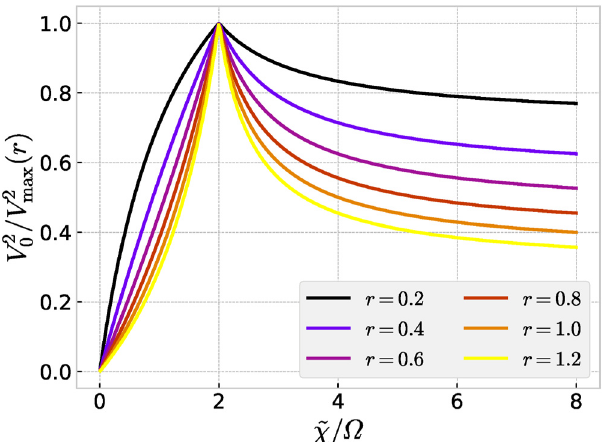
FIG. 5. Schematic of the different parameter regimes of the TaT (LMG) Hamiltonian of Eq. (23) as a function of (cid:22)/ ˜ χ . Depicted are aspects related to metrological state preparation, dynamical quantum phase transitions, ground-state phase quan- tum phase transitions, and classical phase-space